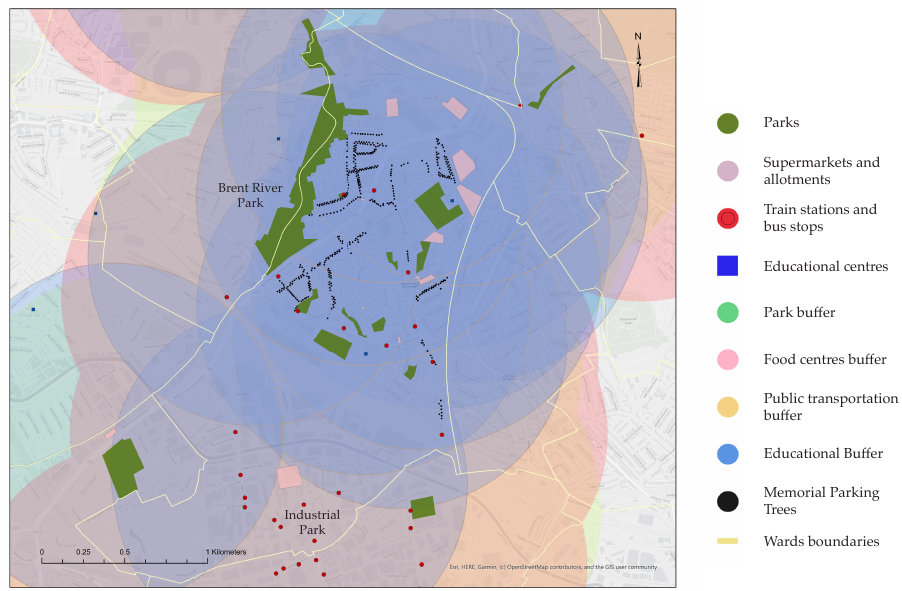
Figure 3. Memorial Parking Trees (MPTs) placement and 15-min city analysis inside the boundary of the ward.